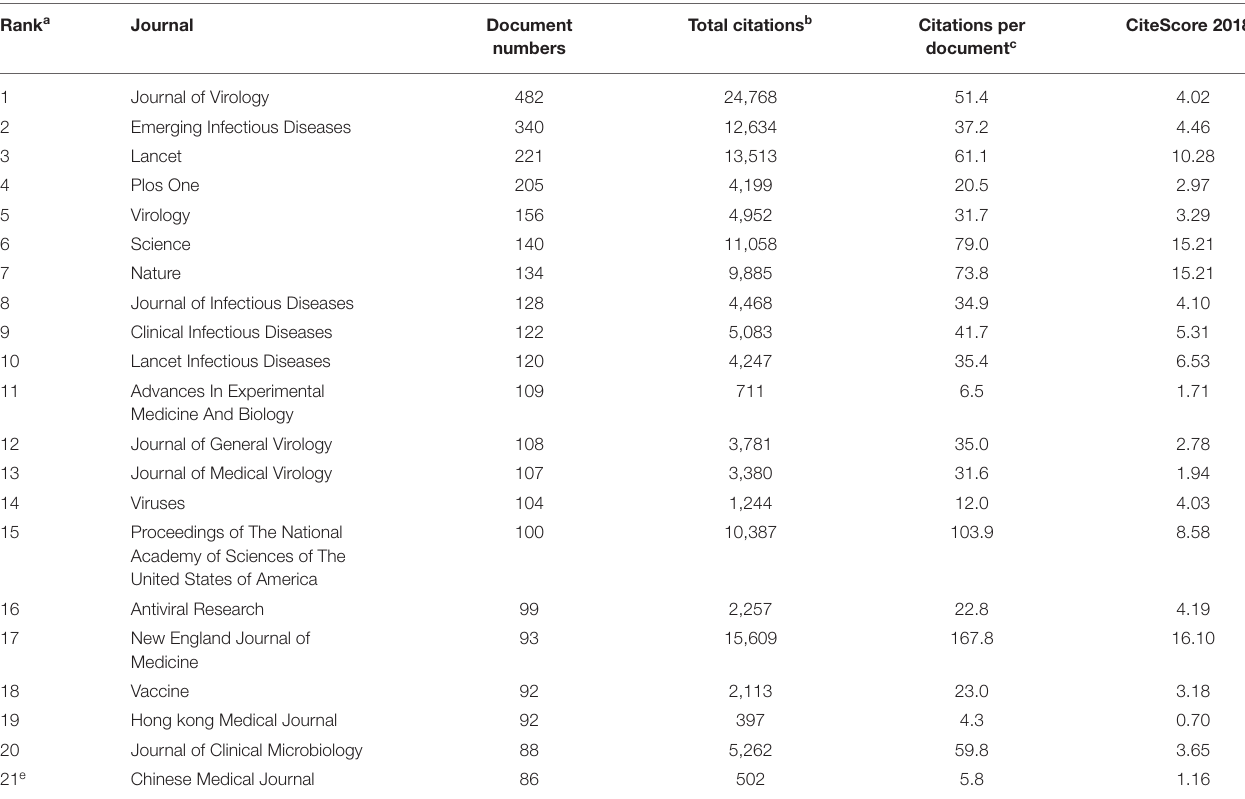
TABLE 3 | Top 20 journals with the most documents.